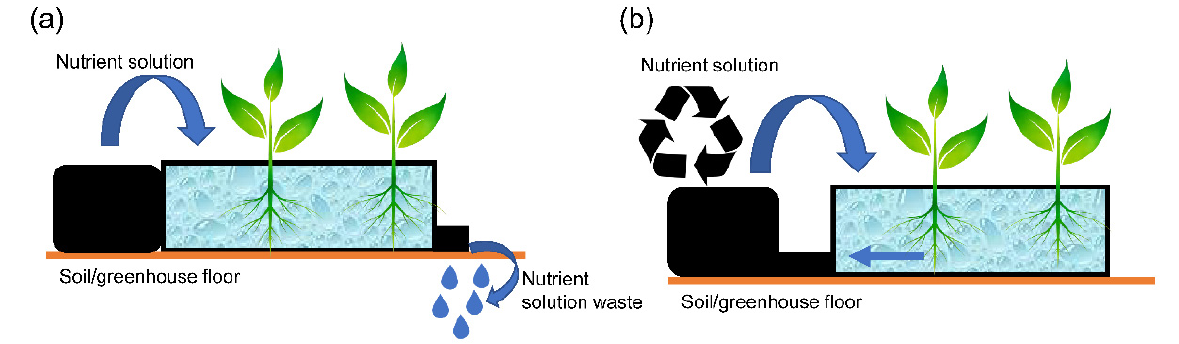
Figure 1. Soilless cropping systems as regards to nutrient solution uses. ( a ) A scheme of an open-loop system in which nutrient solution residues are not recycled, and ( b ) a scheme of a closed-loop system in which nutrient solution residues are reintroduced into the system.